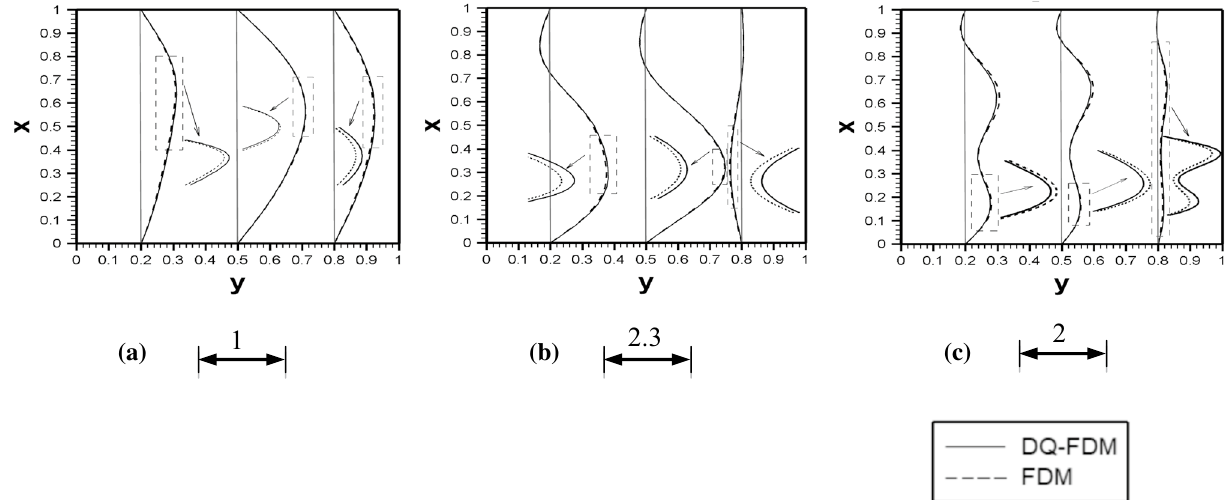
Fig. 5 A sample of comparing the distribution of the velocity of the a longitudinal ( u ), b depth ( v ) and c transverse ( w ) along the length and for passing plate through the middle of the width (t = 0.05,